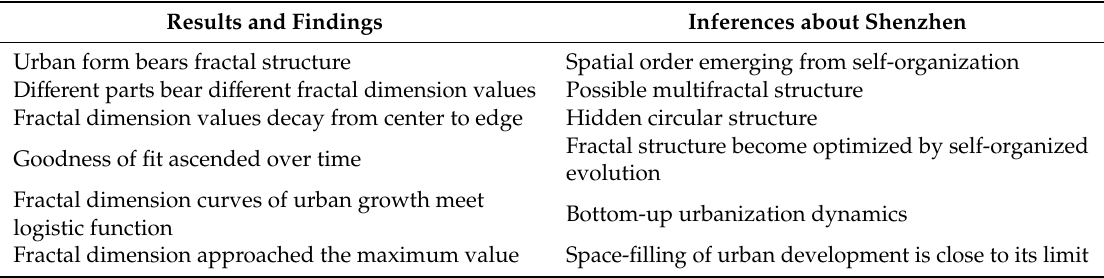
Table 3. The main results and findings of fractal studies and corresponding inferences or conclusions about Shenzhen